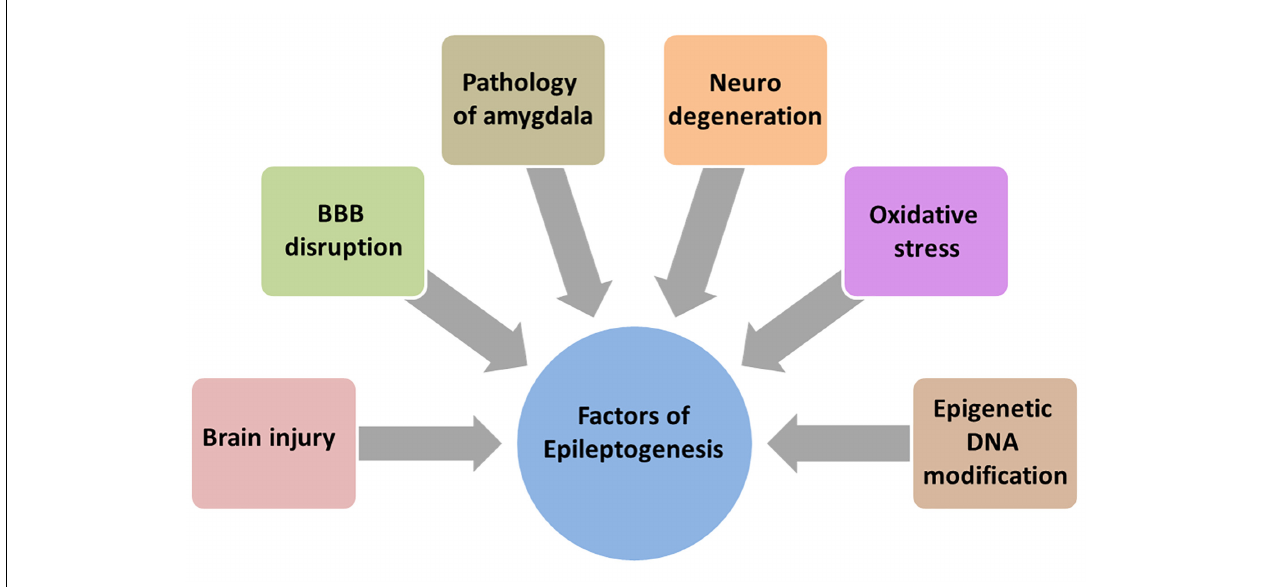
FIGURE 3 | Array of factors contributing to epileptogenesis. Much is unknown about the precise mechanism of epileptogenesis making it difficult to design and develop new therapies. But there is an increased understanding that brain injury, BBB disruption, neurodegeneration, oxidative stress, epigenetic DNA modification and pathology of amygdala contribute and aggravate the